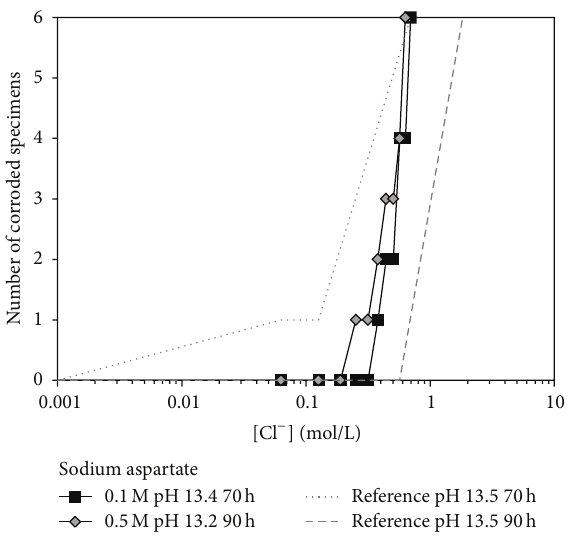
Figure 7: Number of corroded specimens as a function of chloride addition during potentiostatic test in solutions with sodium aspar-